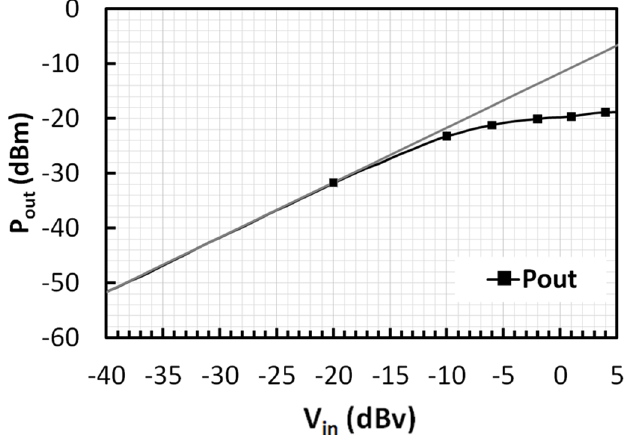
Figure 20. The measured 1-dB compression point of the TX analog baseband.